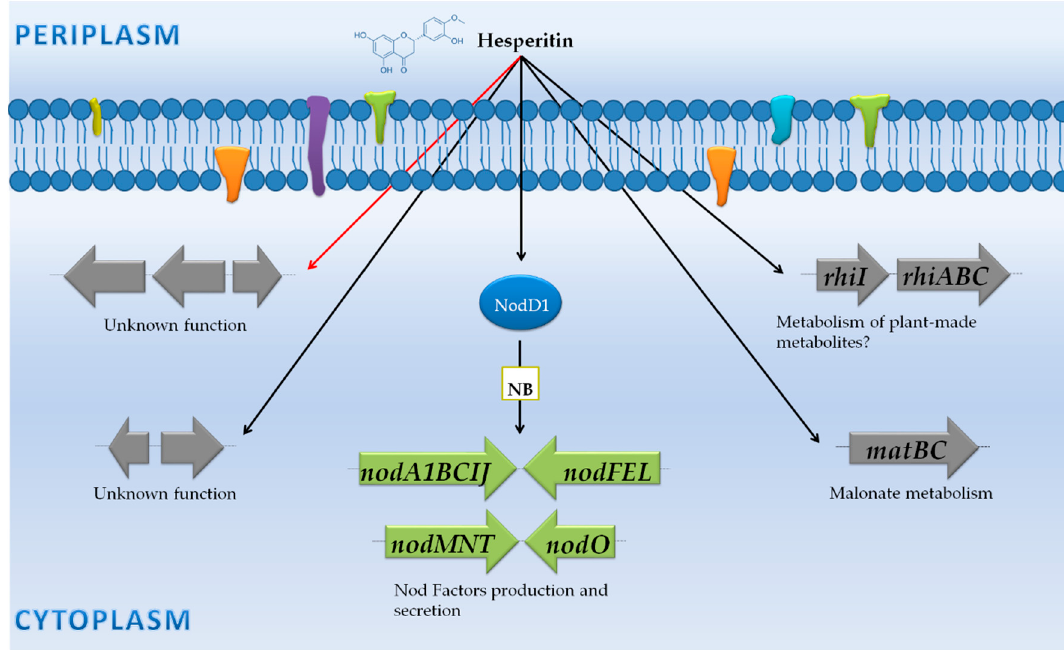
Figure 3. Transcriptomic response in the presence of hesperetin in R. leguminosarum bv. viciae 3841. Proteins are illustrated by blue circles. Activation and repression of genes are indicated by black and red arrows, respectively. Genes regulated by a nod box are represented in green. Genes which are not controlled by a nod box are indicated in grey.